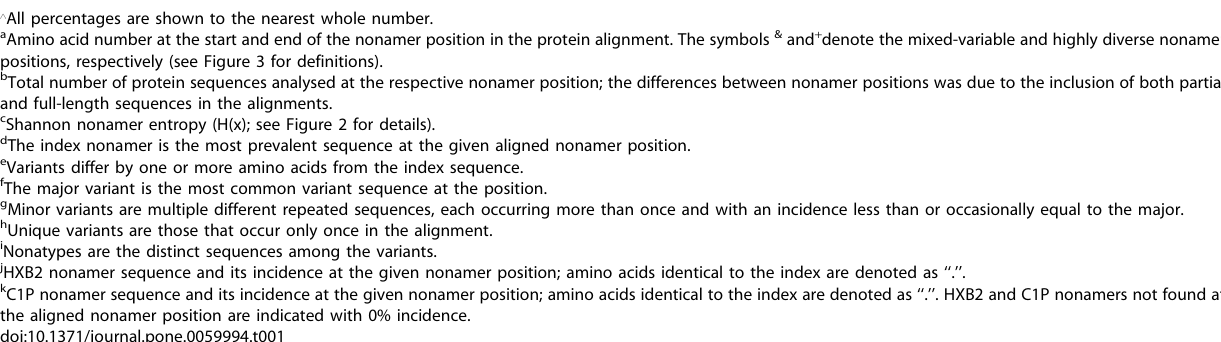
Aligned nonamers H(x) c Index d Variants e Nonatypes i HXB2 j Position a No.